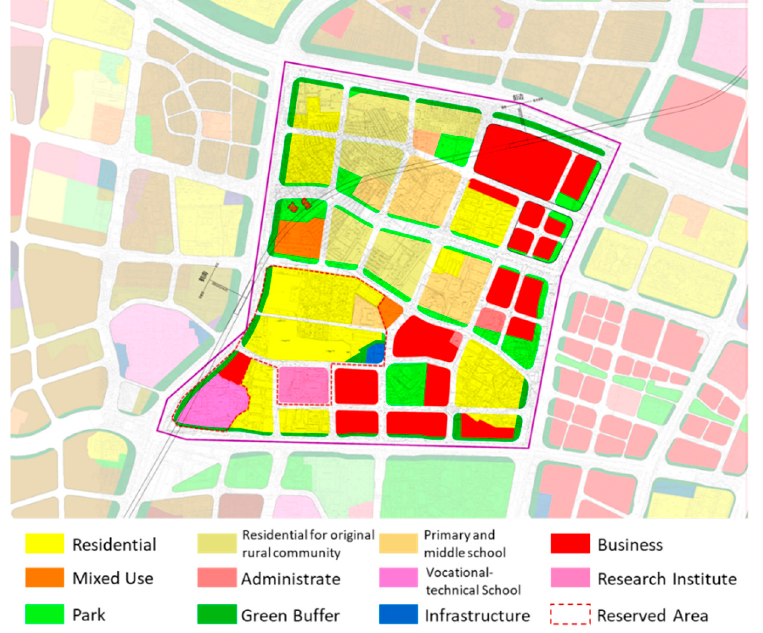
Figure 10. The detailed plan of the H-village redevelopment project after zoning adjustment (the newly built part consisting of 13 parcels of residential, 4 parcels of educational, and 15 parcels of business).